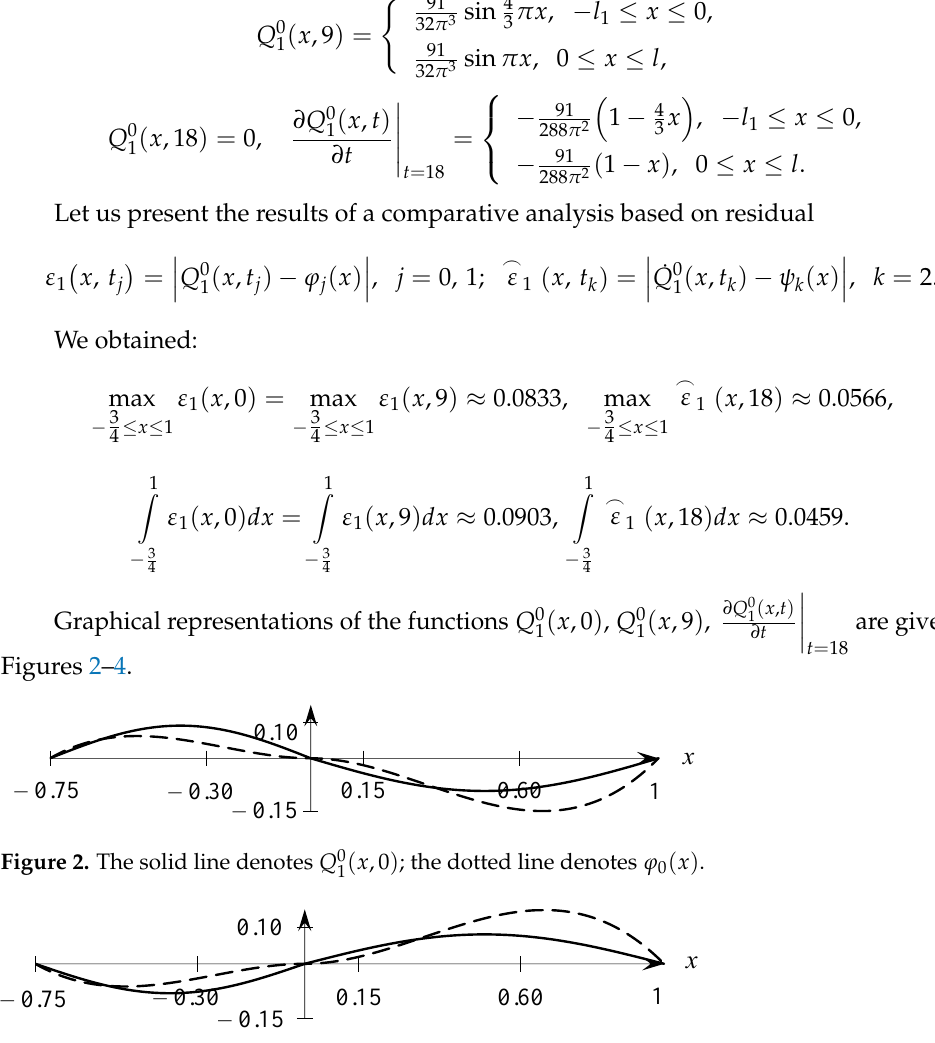
( x ,9 ) ; the dotted line denotes ϕ 1